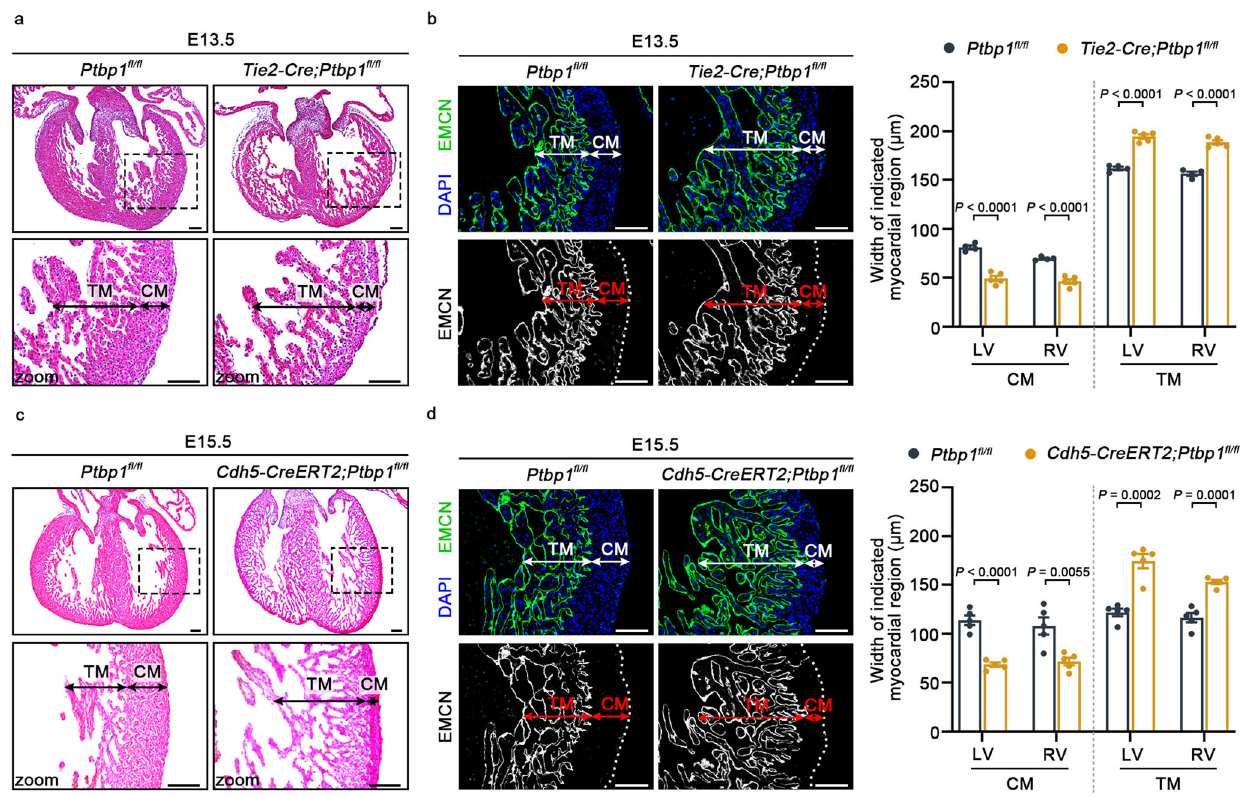
Fig. 3 | Ptbp1 knockout in pan-endothelial cells causes ventricular non- compaction. a H&E staining showing the trabecular myocardium (TM) and com- pact myocardium (CM) in E13.5 Ptbp1 fl / fl and Tie2-Cre ; Ptbp1 fl / fl heart sections. Scale bars, 100 µ m. b Immuno fl uorescence staining of endomucin (EMCN) in E13.5 Ptbp1 fl / fl and Tie2-Cre ; Ptbp1 fl / fl heart sections. The graph shows the quanti fi cation of the CM and TM thickness. n =4 mice for Ptbp1 fl / fl group and n =5 mice for Tie2-Cre ; Ptbp1 fl / fl group.Scalebars,100 µ m. c H&EstainingshowstheTMandCMin